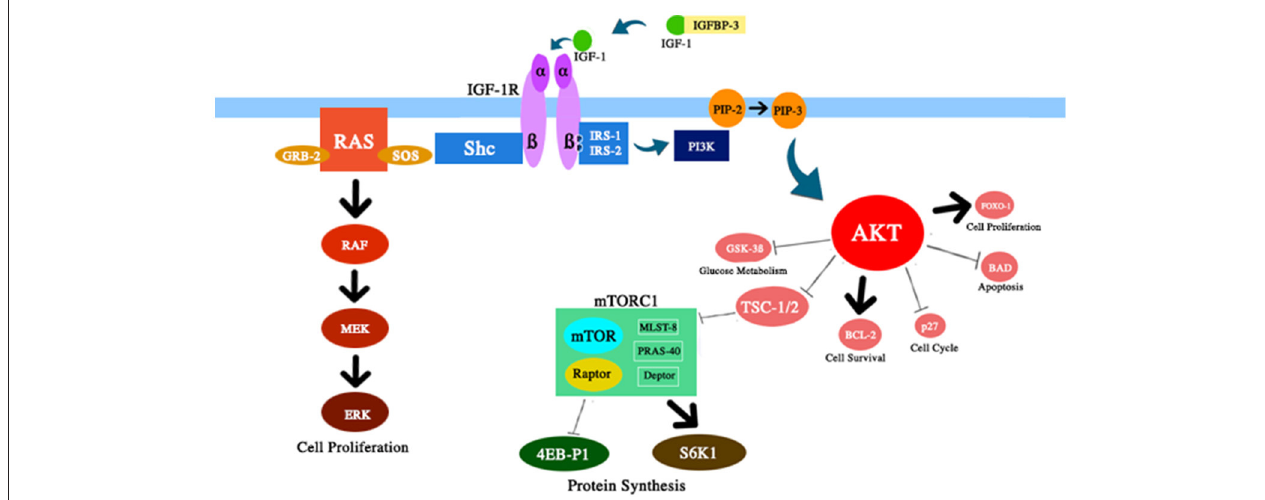
FIGURE 2 | Schematic and simplified representation of the several components of the IGF-1/PI3K/AKT/mTOR pathway discussed in this review. IGF-1 increases the activity of AKT protein with relevant effects on cell survival and proliferation, glucose metabolism and protein synthesis.